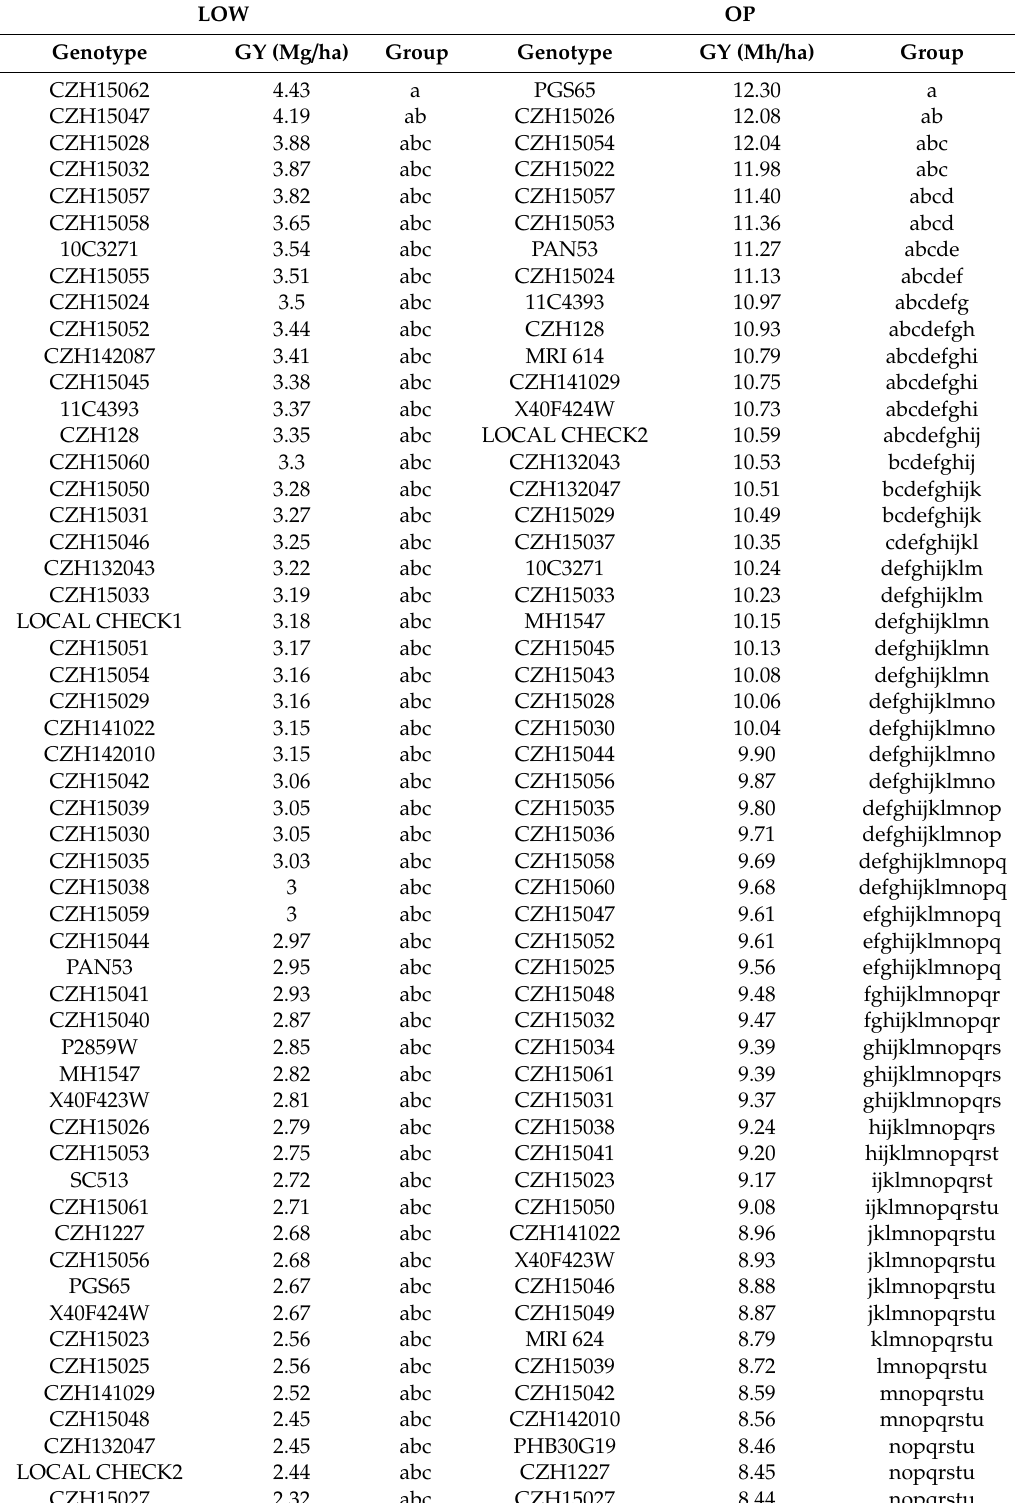
Table A1. The LOW and OP treatment with ANOVA analysis, following with a post